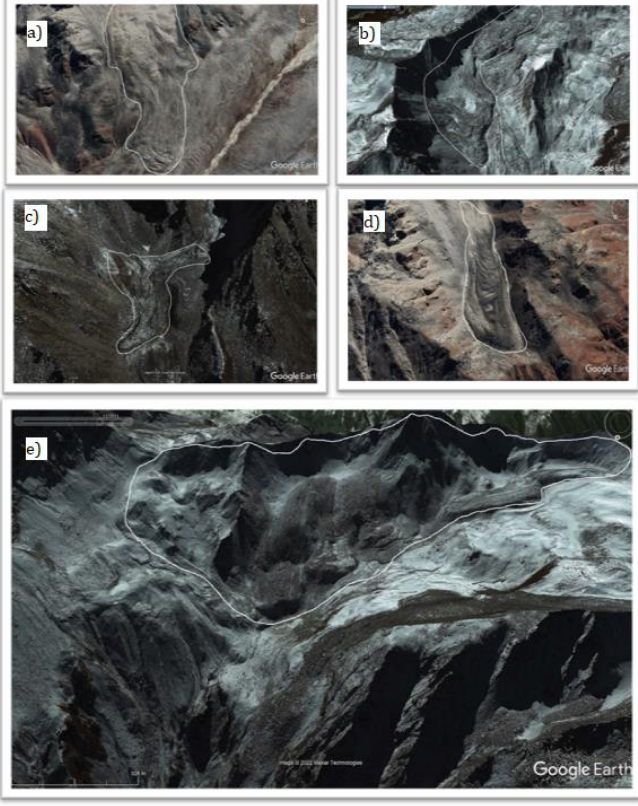
Figure 5: Map of study area showing the distribution of Continuous, Discontinuous, and Sporadic Permafrost with Glacier boundary using the MNAT (Mean Novennial Air Temperature) from the year 2013 to 2021.